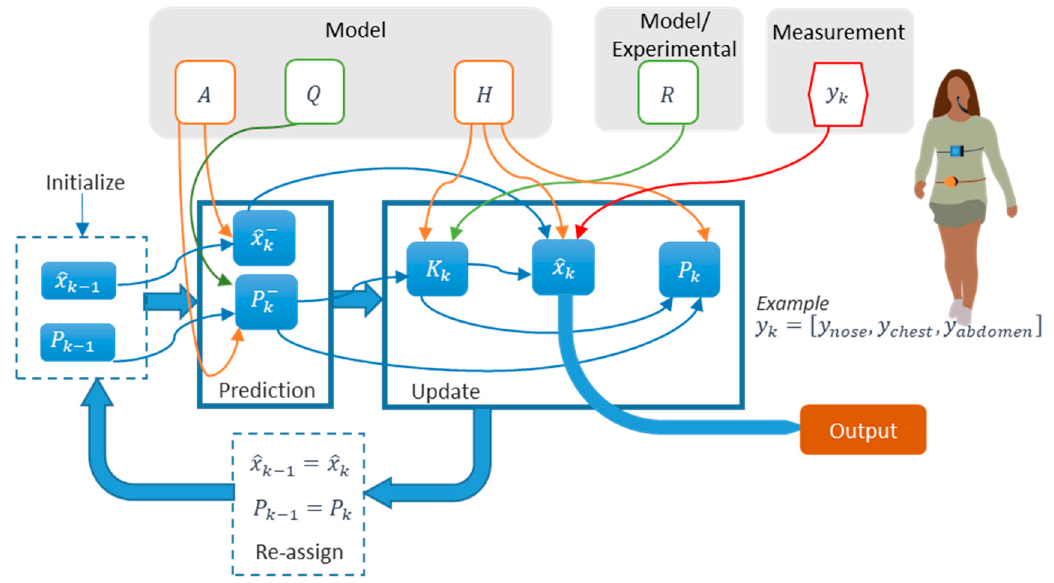
Figure 33. Kalman filter algorithm for the fusion of different respiration sensors.